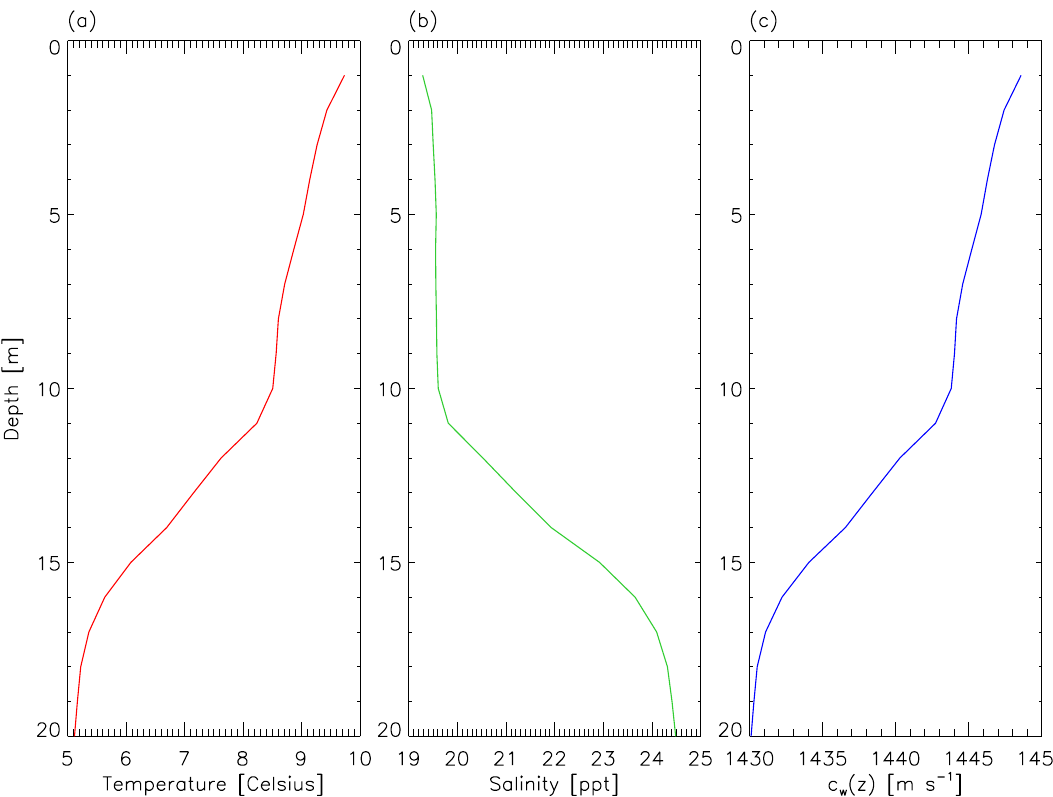
Figure 9. ( a ) Average water temperature profile. ( b ) Average water salinity profile. ( c ) Corresponding average speed of sound profile. CTD data were retrieved from the Observatoire global du Saint-Laurent archives and were gathered from June to August between 2006 and 2010. Most of the data were gathered off the Kamouraska harbor (see Fig. 1). The speed of sound profile is dominated by the drop in temperatures measured at depths greater than 10